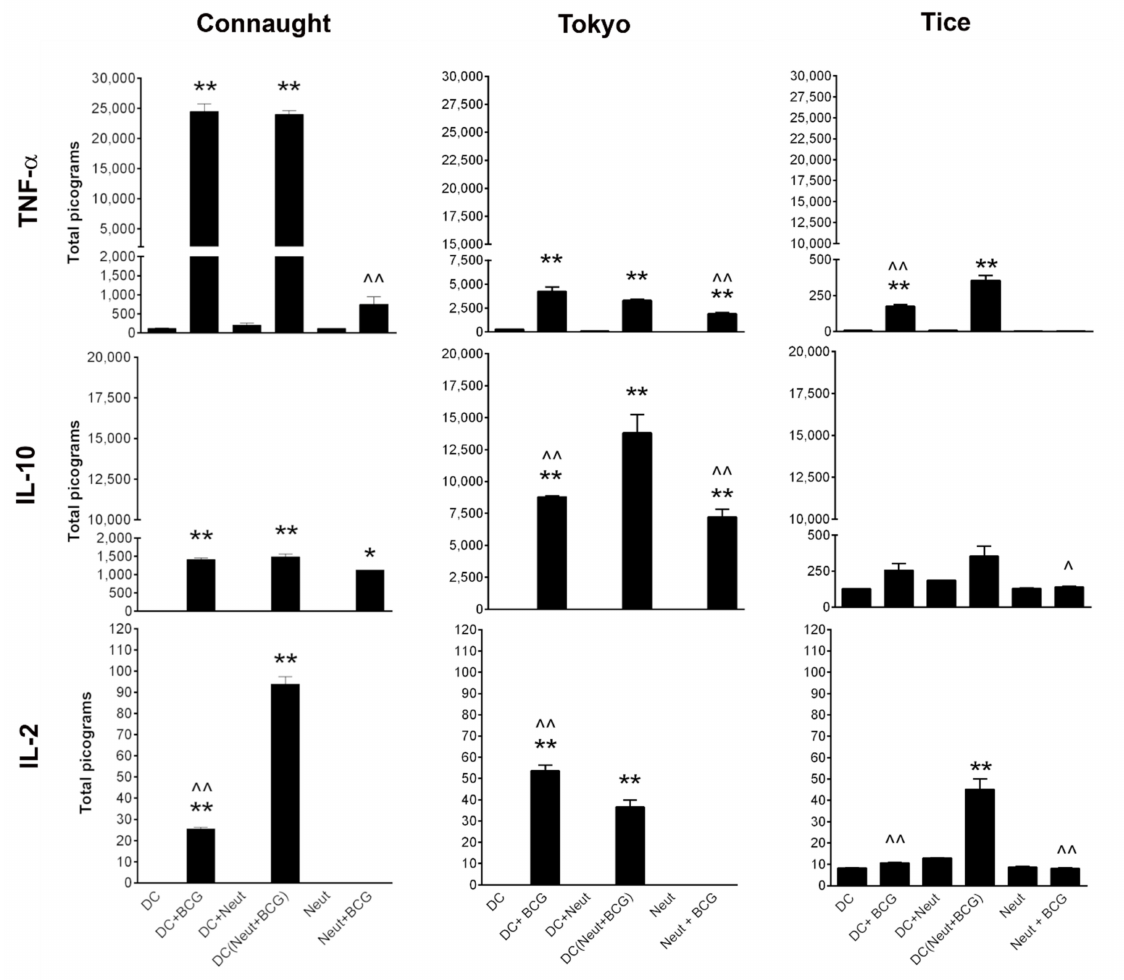
Figure 1. In vitro cytokines produced by murine bone marrow-derived dendritic cells (DC) and neutrophils (Neut) stimulated with BCG Connaught, BCG Tokyo and BCG Tice strains at MOI of 1:5. Immune cells were exposed to BCG for 2 h and then removed. TNF α , IL-10, and IL-2 production were measured in the supernatant 16 h later. In DC (neut + BCG), neutrophils were first exposed to BCG for 2 h and DC was stimulated with BCG activated neutrophils. One-way ANOVA with a Bonferroni post-hoc analysis was used for comparison among multiple groups. * denotes significance compared to respective control and ˆ denotes significance compared to DC (Neut + BCG) group. *, ˆ p < 0.05, **, ˆˆ p <